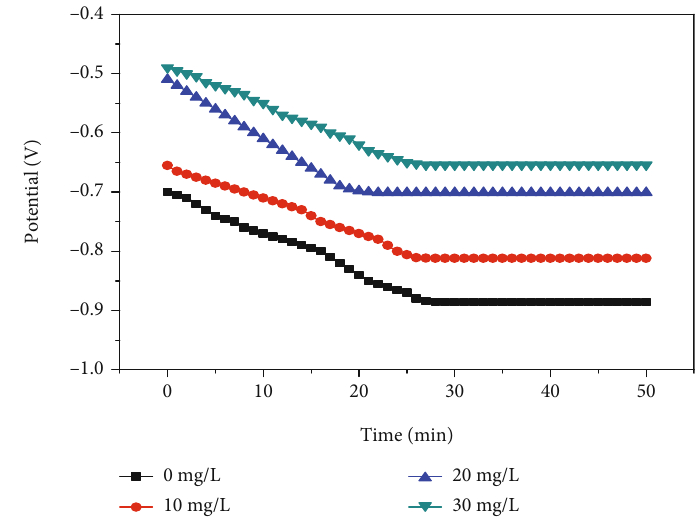
Figure 11: Corrosion potential curve with